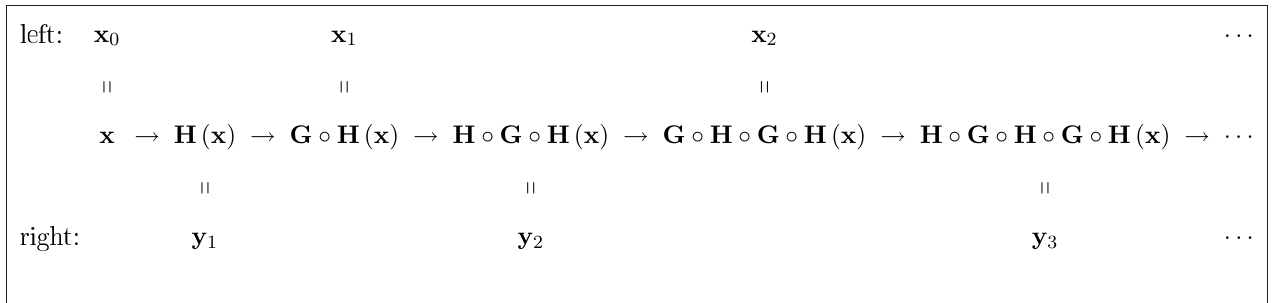
Figure 2 | A chain-matched sequence of left and right stimuli. The arrows should be read “is matched by” (i.e., they represent the relation M